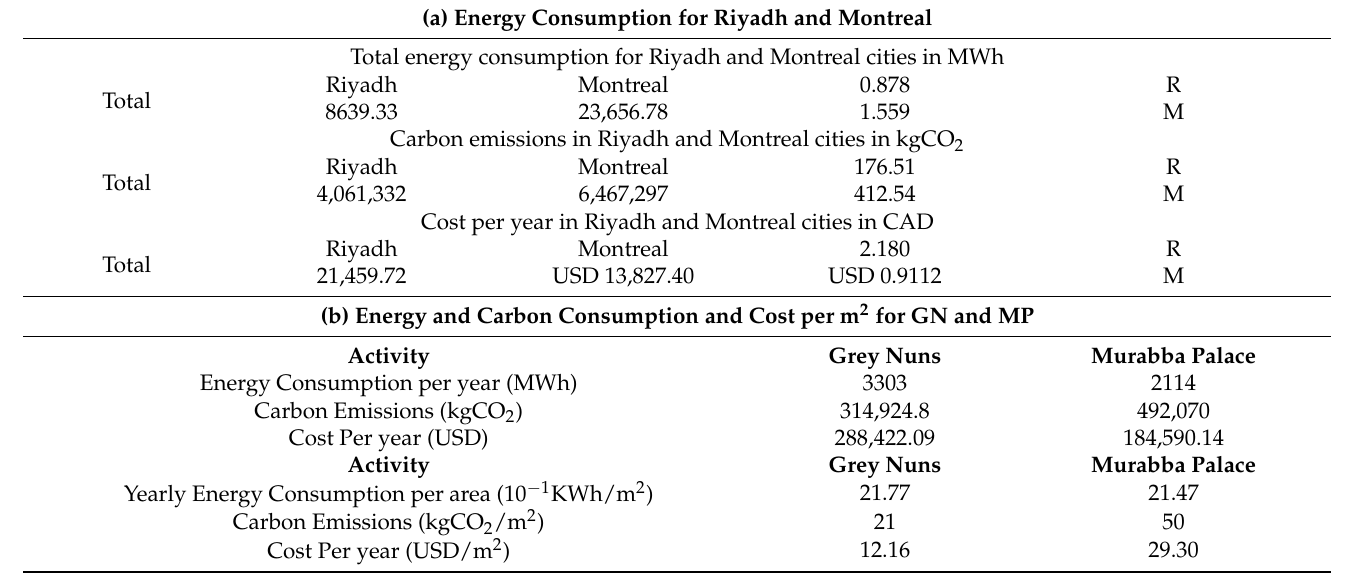
Table 3. Energy consumption for Riyadh and